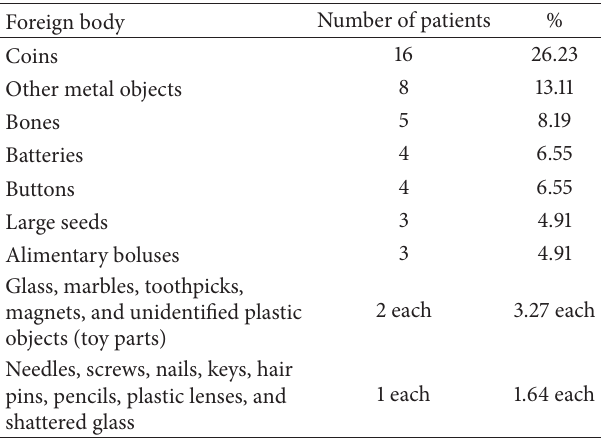
Table 3: Types of foreign bodies encountered in the patient series.